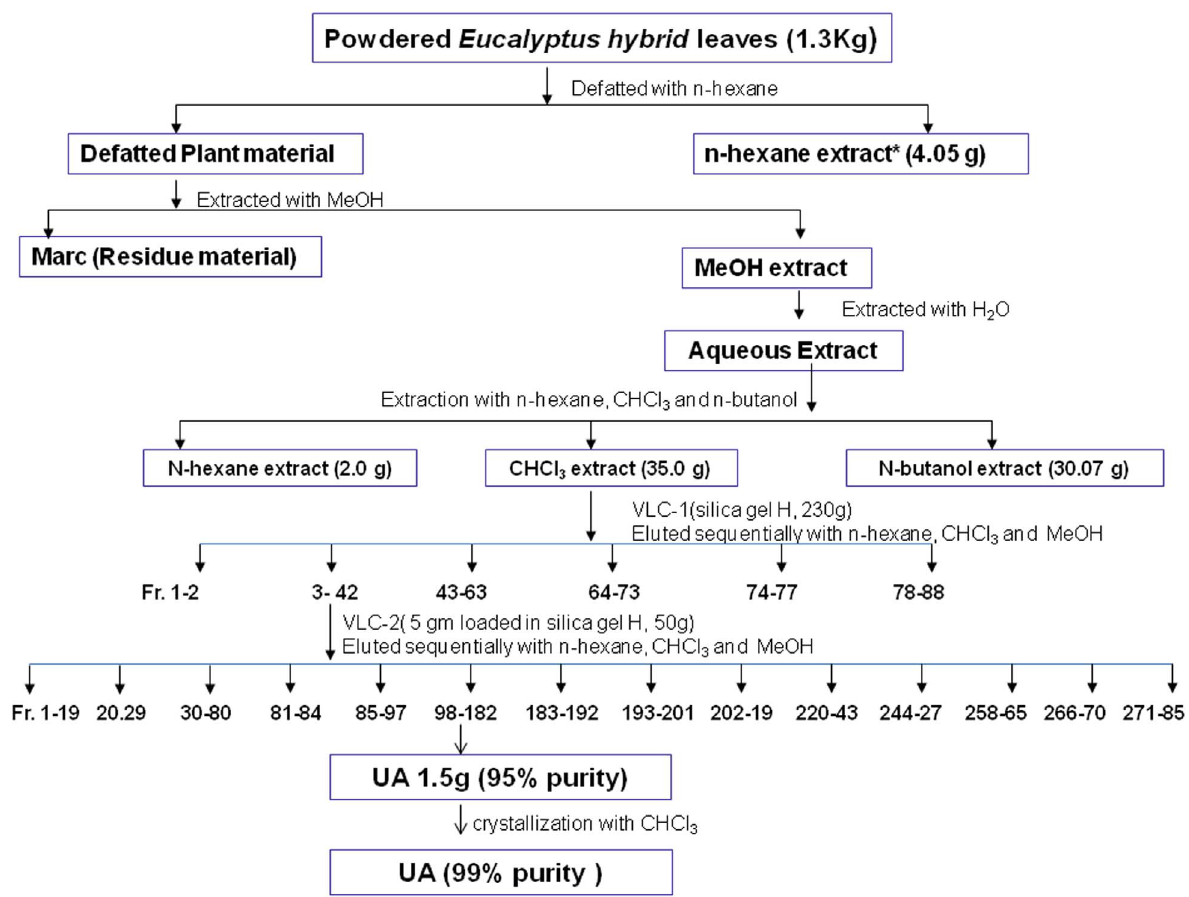
Figure 1. The schematic extraction and fractionation of UA from the leaves of E.tereticornis . $ Washed with water and the solvent was dried over anhydrous Na 2 SO 4 . * Solvent was completely removed under vacuum at 35 u C on a Buchi Rota vapour.